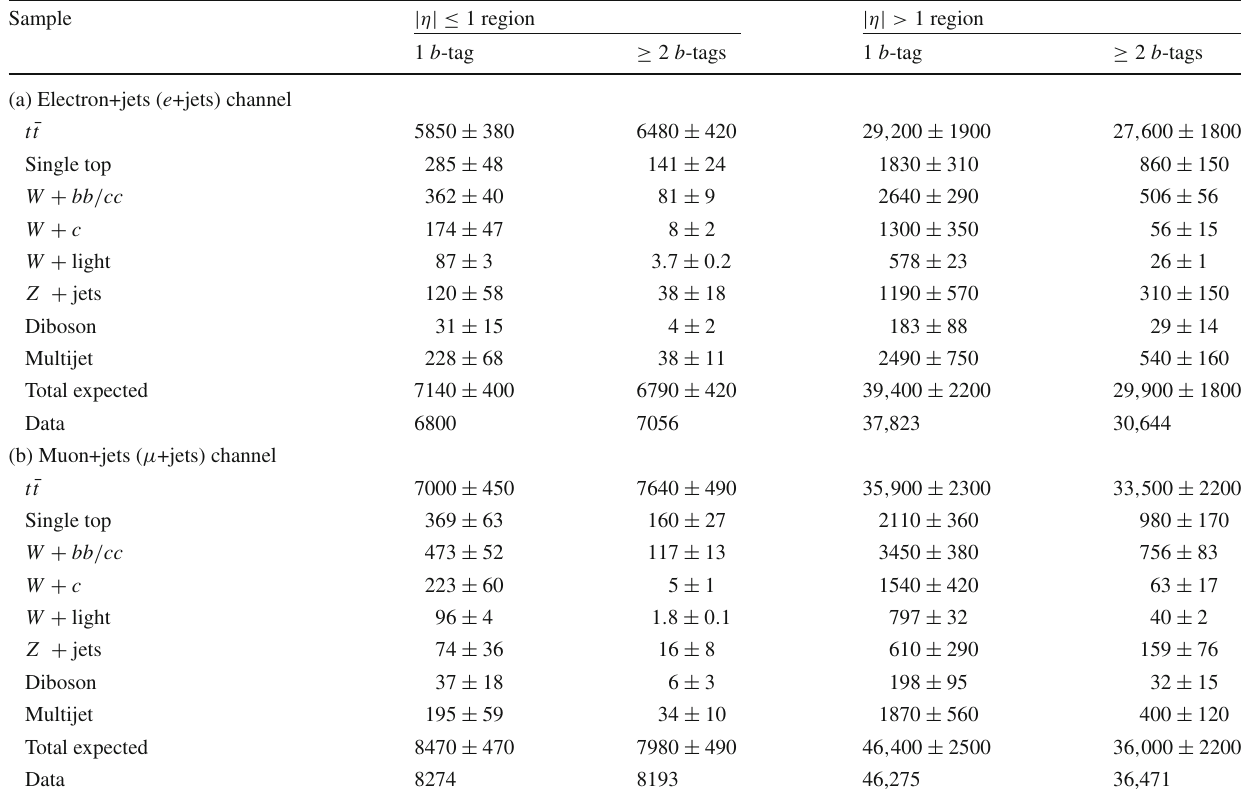
Table 1 Event yields after the event selection in the (a) electron+jets and (b) muon+jets channel for events with exactly one or at least two b -tags divided into events where all four jets associated with the t ¯ t decay have | η | ≤ 1 and events where at least one jet has | η | > 1. The uncertainties in the signal and background yields arising from normali-